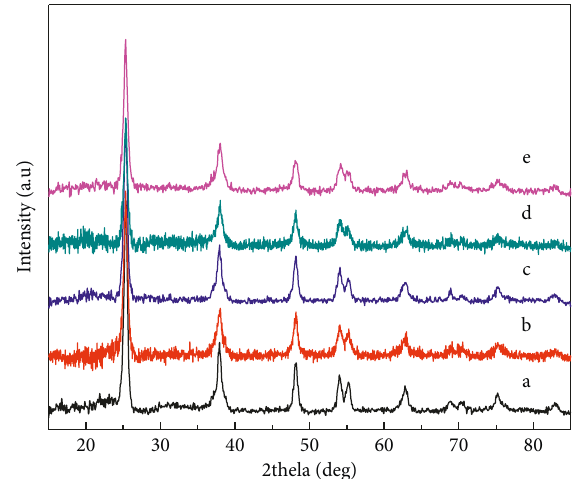
Figure 3: X-ray diffraction patterns of (a) bare TiO 0.5 at%, (d) 1.0 at%, and (e) 2.0 at% of Fe-doped TiO 2 .